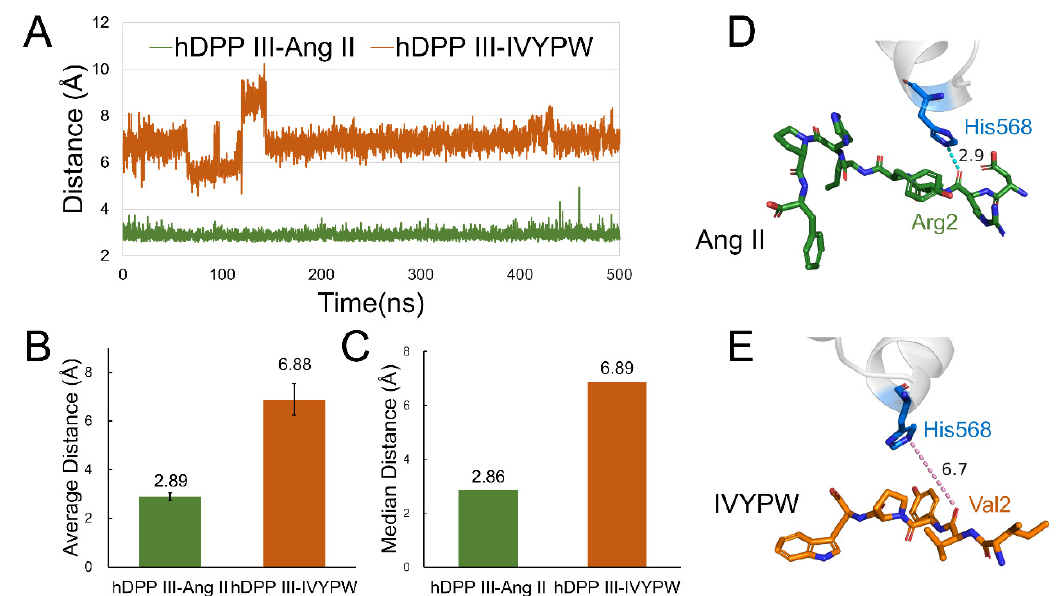
Figure 7. The distance between the ε nitrogen atom in His568 of hDPP III and the oxygen atom in the second residue of the substrates (N-O distance). ( A ) N-O distance throughout the 500 ns molecular dynamics simulations. ( B ) Average N-O distance in the 500 ns simulations. ( C ) Median N-O distance in the 500 ns simulations. ( D ) N-O distance in the hDPP III-Ang II complex. His568 is shown as blue sticks and Ang II is shown as green sticks with Arg2 labeled. ( E ) N-O distance in hDPP III–IVYPW complex. His568 is shown as blue sticks and IVYPW is shown as orange sticks with Val2 labeled.